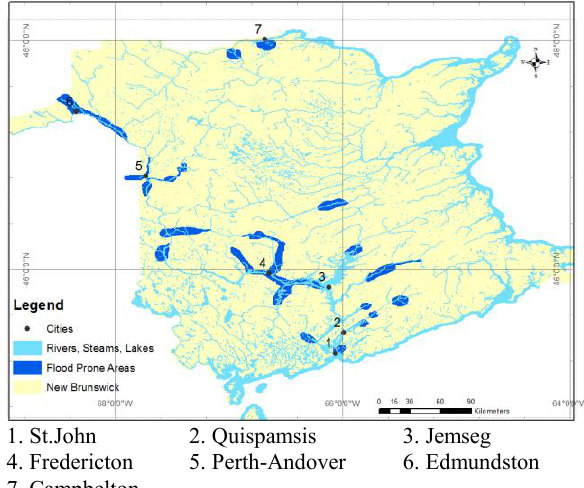
Figure 1 Distribution of areas prone to major flood damage in New Brunswick, adapted from Franklin and Cardy, 1976.